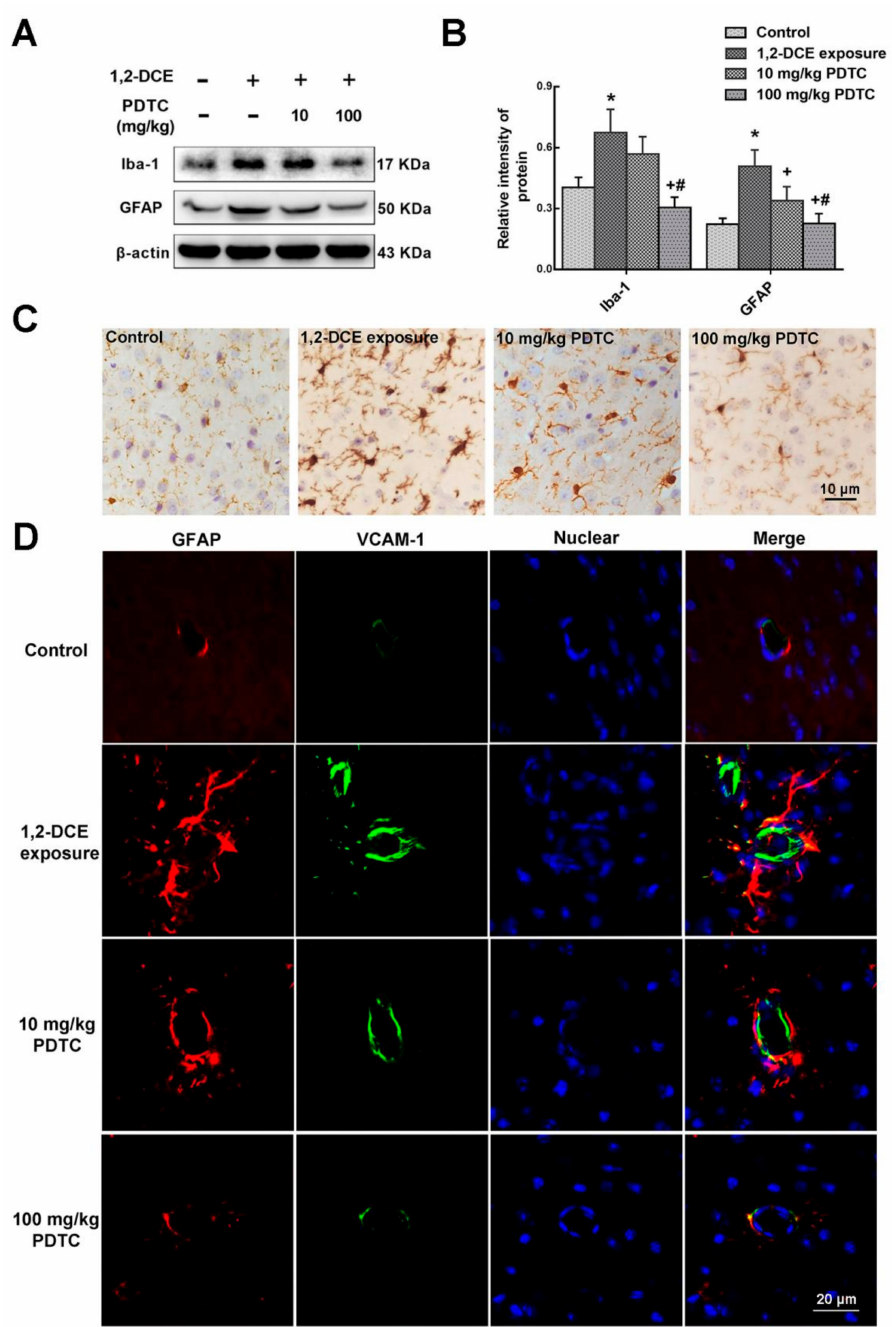
Figure 4. Involvement of NF- κ B in upregulation of Iba-1 and GFAP expression in 1,2-DCE-intoxicated mice. ( A ) Representative images of Western blot analysis. ( B ) Graphs show the densitometric quantitation of Iba-1 and GFAP, which were normalized to the intensity of β -actin. ( C , D ) The photomicrographs of immunocytochemistry and immunofluorescence represent staining of Iba-1, GFAP, and VCAM-1 in the frontoparietal region of the cerebral cortex, respectively, which are representative of five separate experiments and were captured using a Nikon microscope (200 × ). Scale bar represents 10 µ m and 20 µ m, respectively. Data expressed as mean ± SD are the results of five independent experiments and analyzed by one-way ANOVA. Significant di ff erence is defined as p < 0.05, and *, vs. control group; + , vs. 1,2-DCE poisoned group; # vs. low dose intervention